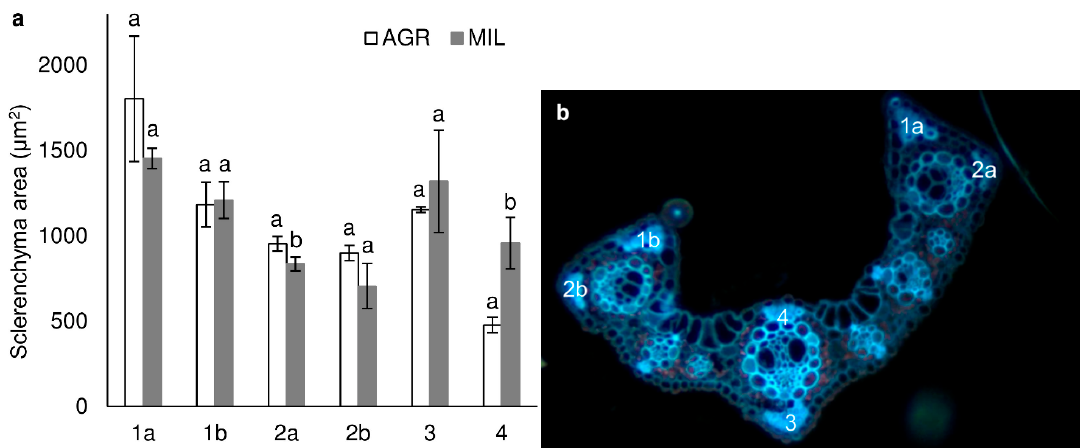
Figure 5. Size of 4 sclerenchyma areas in 1 cm leaf section ( a ) (mean ± SD, n = 3) and sclerenchyma area position ( b ), the same letters above bars mark comparable groups according to T-test ( p < 0.05) – only results for AGR and MIL for the same sclerenchyma area are compared mutually.